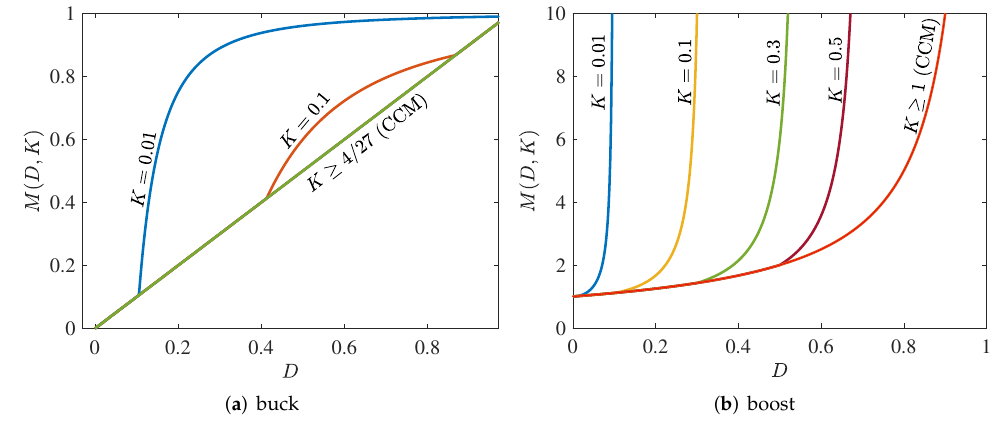
Figure 9. The conversion gain M ( D , K ) for the buck and the boost converter for different values of dimensionless parameter K . The conversion gain for CCM is also shown for